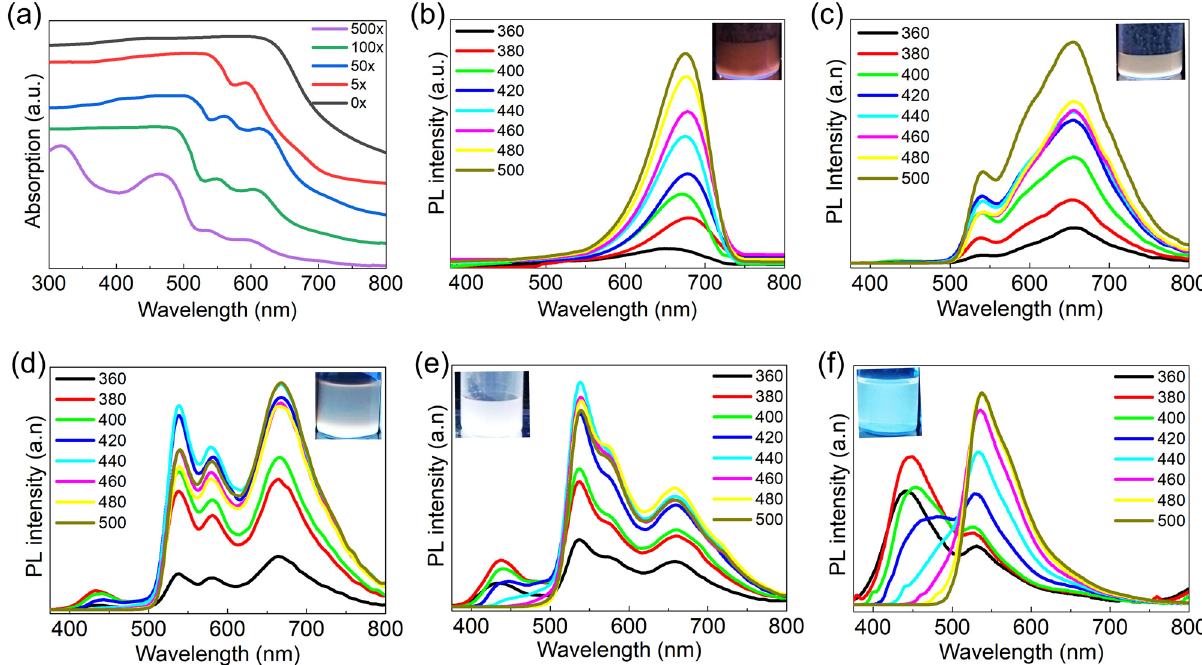
Figure 4: ( a ) UV - Vis absorption spectra of CQDs synthesized by adding 5 times ( red solid line, 5 ×) , 50 time ( blue solid line, 50 ×) , 100 times ( green solid line, 100 ×) , and 500 times ( purple solid line, 500 ×) DMF dilution ratios into RCQDs solution, and the original RCQDs was denoted as “ 0 ” ( black solid line ) , respectively. The PL emission spectra of RCQDs diluted by DMF in ( b ) 0 times, ( c ) 5 times, ( d ) 50 times, ( e ) 100 times, and ( f ) 500 times at di ff erent excitation wavelengths ( 360 – 500 nm ) , respectively. Insets are photographs of the solutions under 395 nm UV